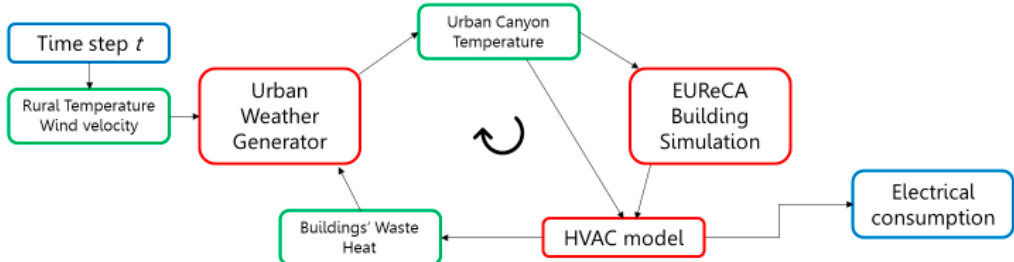
Figure 3. Simplified workflow of the integrated urban heat island model.